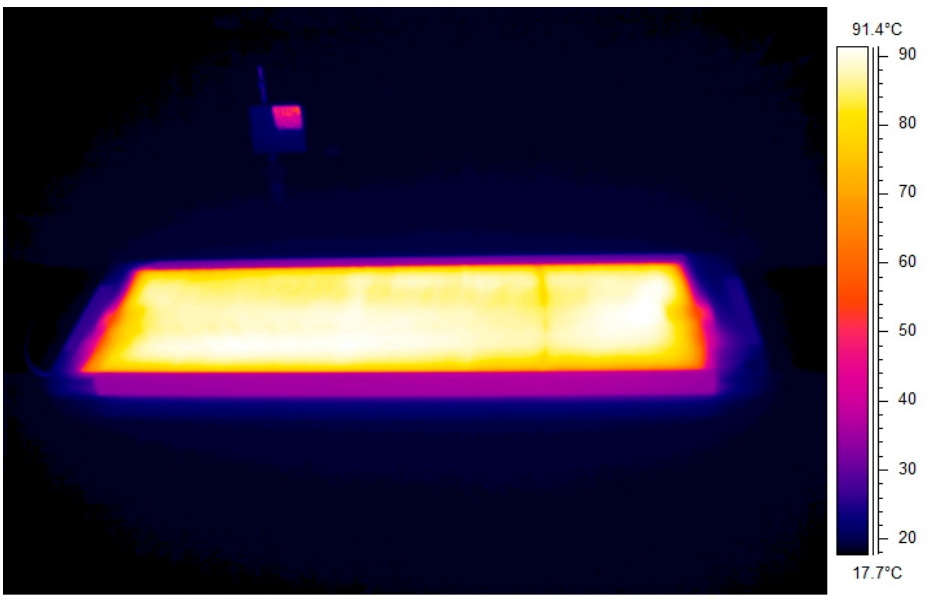
Figure 6. Thermal image obtained at the end of the transient measurement.